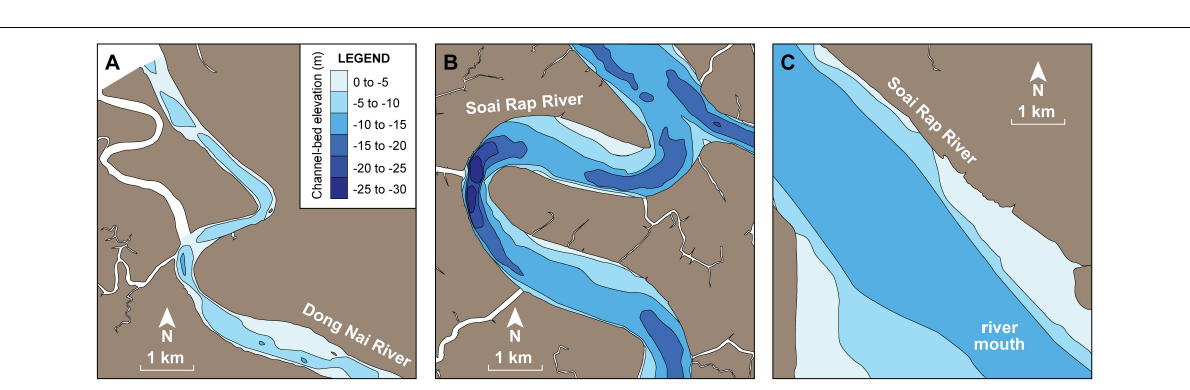
FIGURE 5 | Satellite images of selected parts of the Ð`ông Nai–Soài Ra.p River (from Google Earth Pro, Landsat/Copernicus, 2016). (A–C) Areas of valley widening or exit and associated high-sinuosity bends and bifurcations. (D) River-mouth area. See Figure 1C for locations.